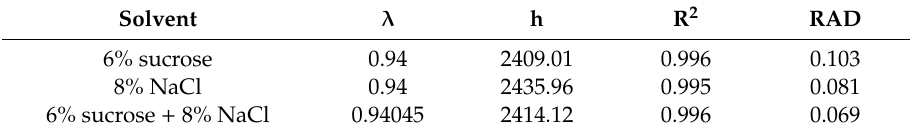
Table 5. Parameters of the λ h model for β -Cyclodextrin in the sucrose, NaCl, and mixed solutions. Solvent